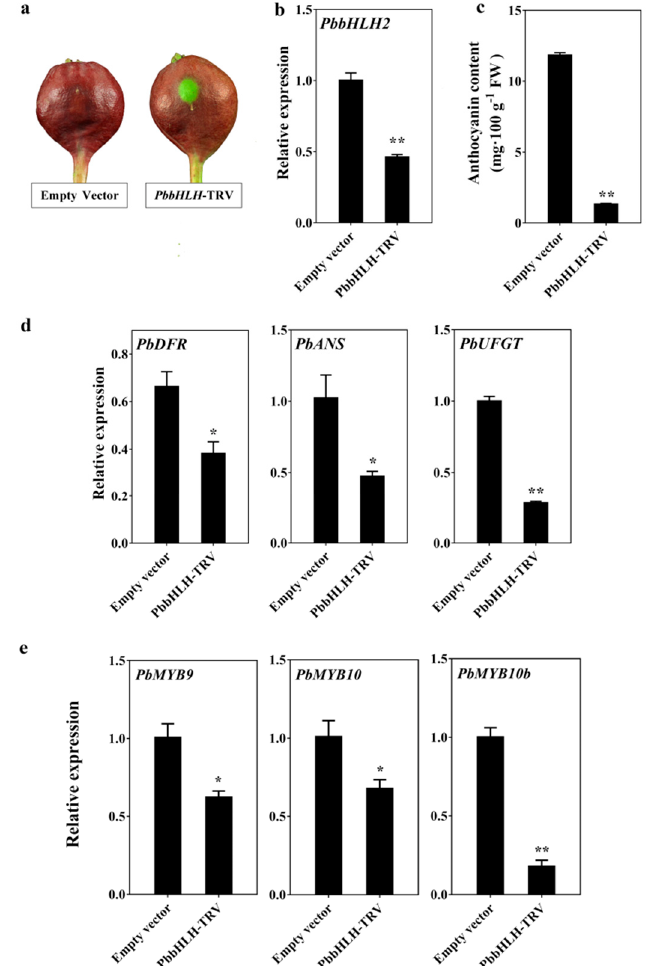
Figure 4. Anthocyanin patterns in transient PbbHLH -RNAi “Palacer” pear fruitlets peel. ( a –e) VIGS assay ( a ); PbbHLH2 expression levels ( b ); anthocyanin contents ( c ); PbDFR , PbANS , and PbUFGT expression levels ( d ); and PbMYB9 , 10 , and 10b genes expression levels ( e ) in transient PbbHLH -RNAi “Palacer” fruitlets peel. The significance levels of difference was analyzed by t-test (* = p < 0.05; ** = p < 0.01). All the data are from three biological replicates and are expressed as means ± SEs ( n = 3). All the tests were computed using SPSS (ver.20.0).